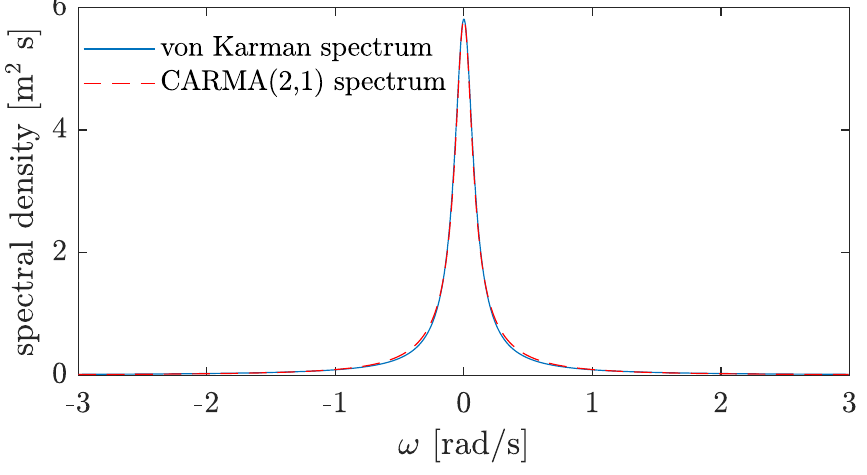
Figure 4. Von Karman spectrum and its CARMA(2,1) approximation for mean wind speed V m = 14 m/s, correlation length L v = 170m/s, and σ v = 1.